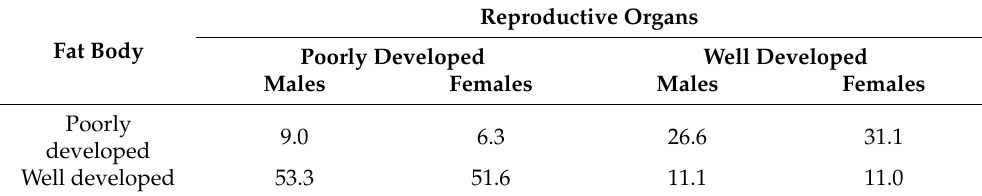
Table 1. The correlation between the development of a fat body and reproductive organs in Haly- omorpha halys males and females (percentages calculated for the pooled data of all photoperiods and populations: 696 males and 630 females; see text for details of statistical analysis). Reproductive Organs Fat Body Poorly Developed Males Females Males Females